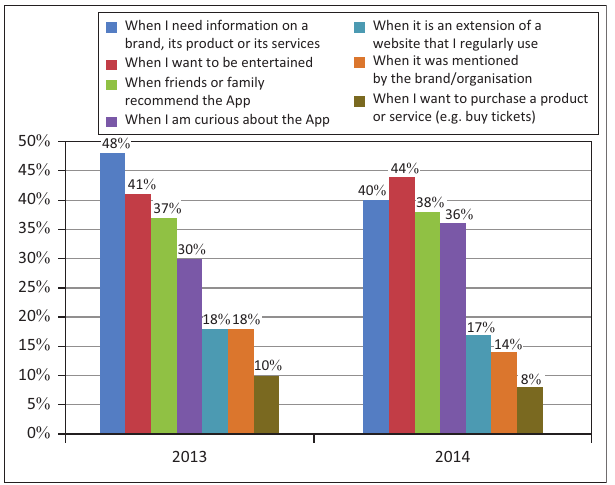
FIGURE 3: Motivation for searching for an app, 2013 vs. 2014.